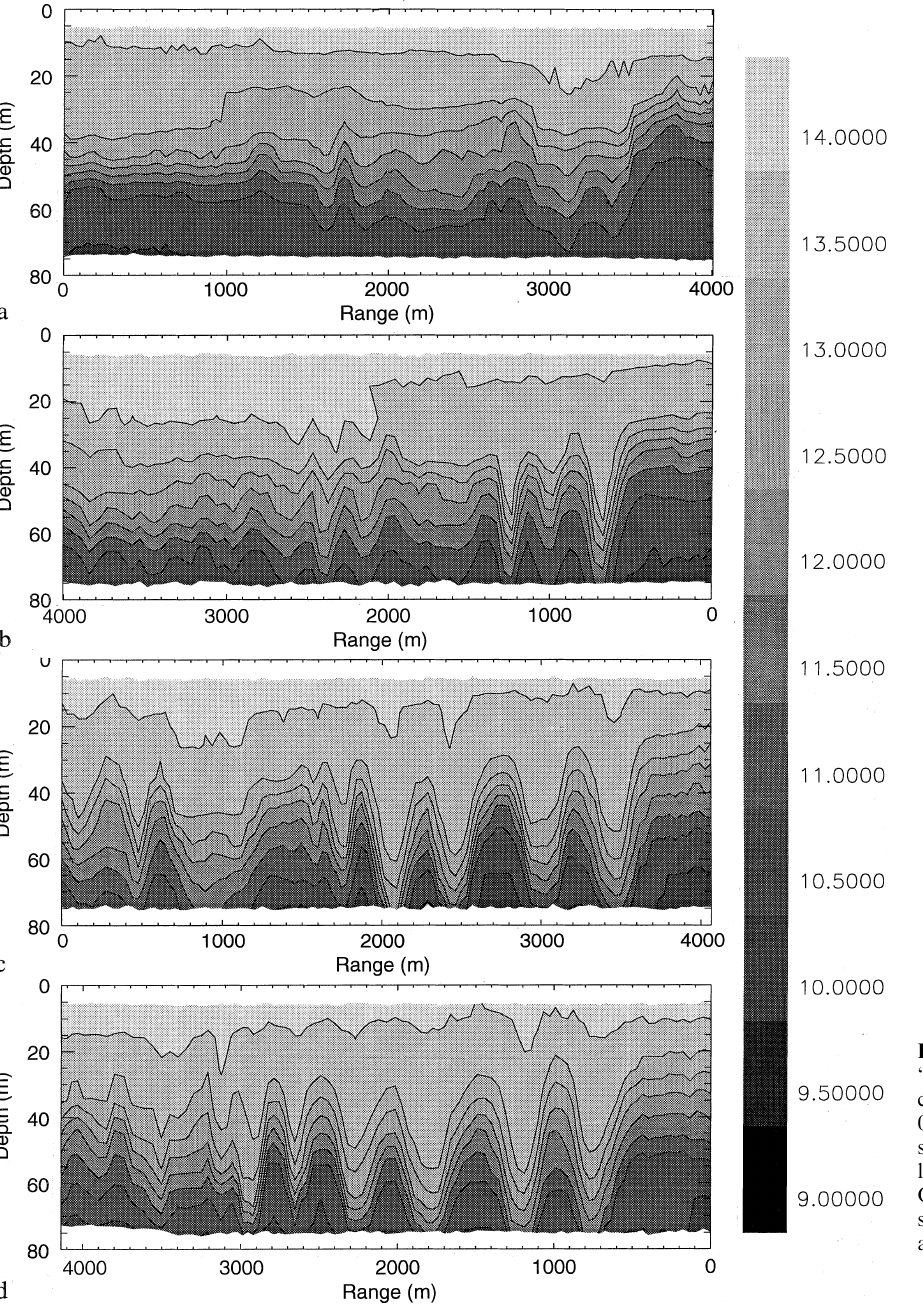
Fig. 5a–d. ‘Snapshots’ of the feature ‘ A ’ derived from Fig. 4 by assuming a constant wave speed across ground of 0.3 m/s, and removing the Doppler shift. Cross sections of four kilometre lengths are shown for consistency. Once again all plots are aligned to show the feature at the right . Temper- ature in